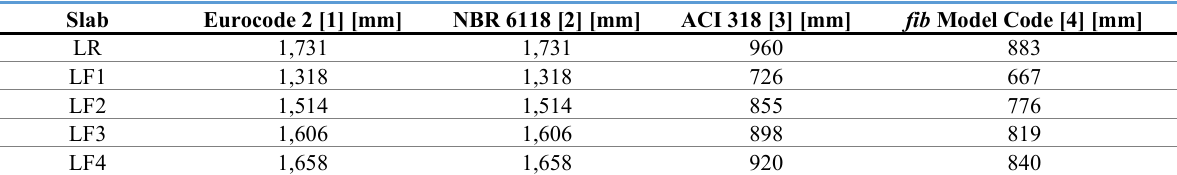
Table 5. Effective control perimeter lengths.